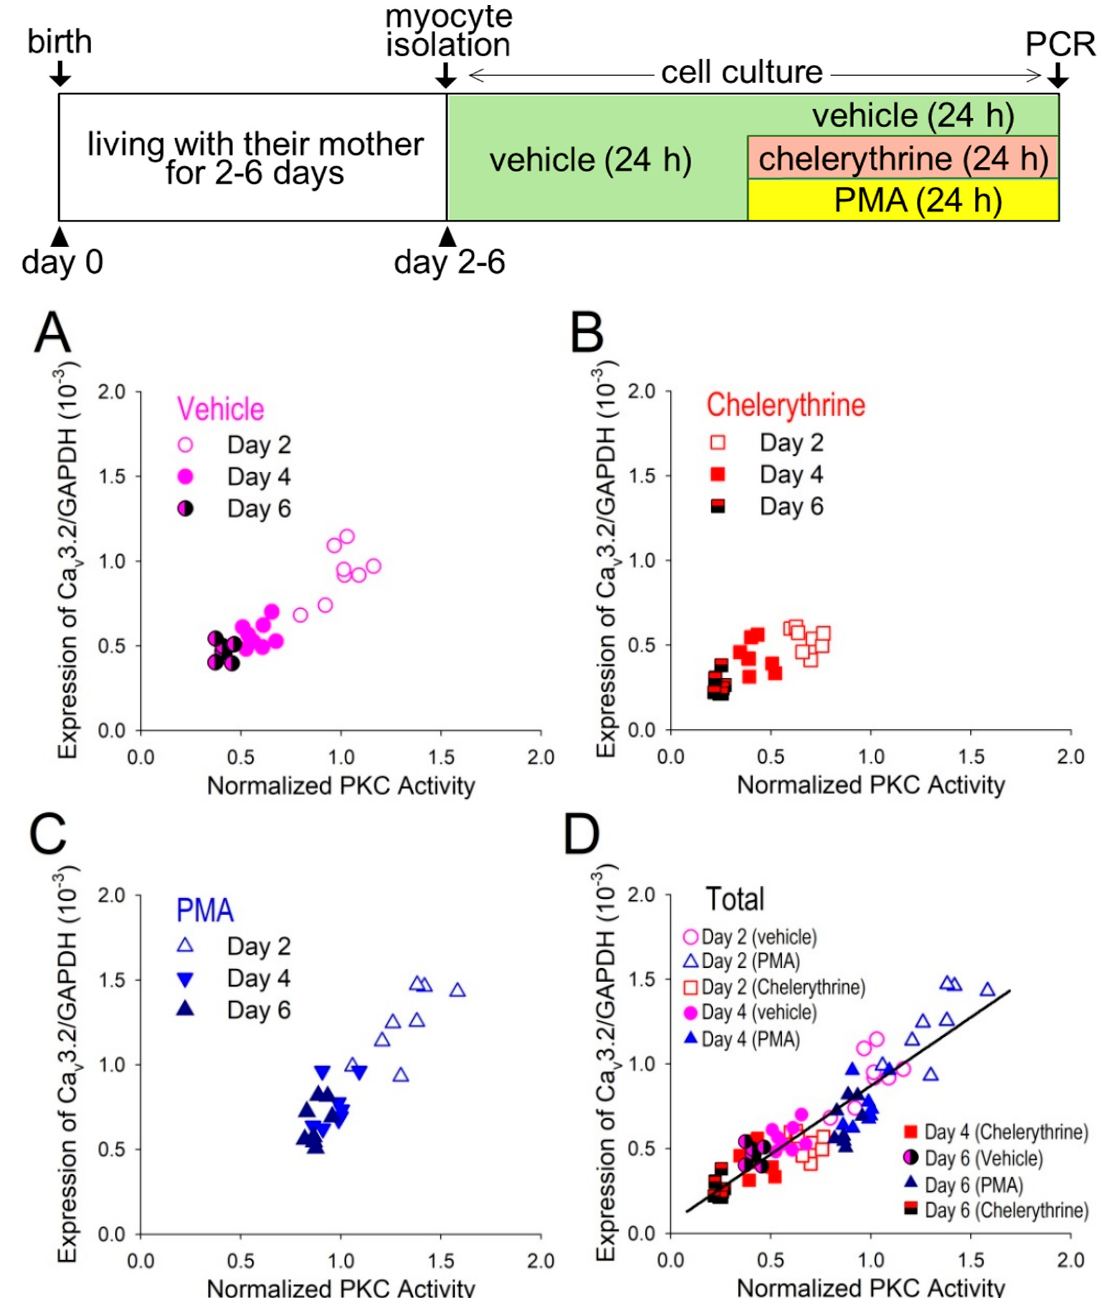
Figure 6. Relation between PKC activity and Cav3.2-mRNA expression. Expression of Cav3.2 mRNA was assessed by real-time PCR and plotted against PKC activity in myocytes isolated at day 2, 4 and 6, treated in vehicle ( A ), 2 µ M chelerythrine ( B ), or 1 µ M PMA ( C ). Whole data set from myocytes treated in vehicle, chelerythrine or PMA were plotted in terms of Cav3.2 mRNA level against PKC activity and assessed by linear regression analysis with the coefficient of determination (Rsqr) of 0.828 ( D ). Note that chelerythrine and PMA were washed out in the culture medium prior to the electrophysiological study. Protocols for myocytes isolation and cell culture are shown in the inset above.